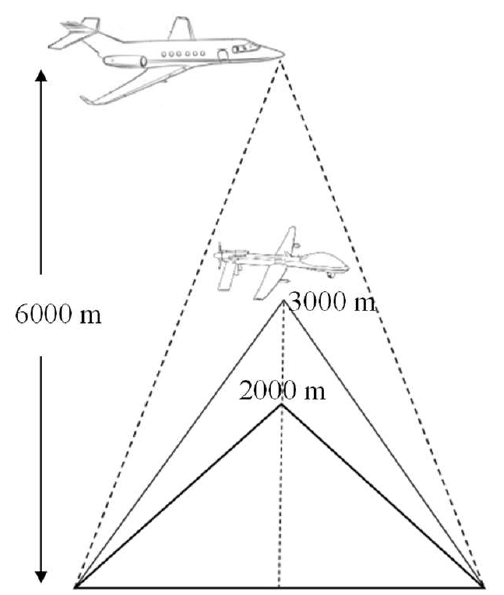
Figure 4. Relationship between working altitude and FOV of a UAV.